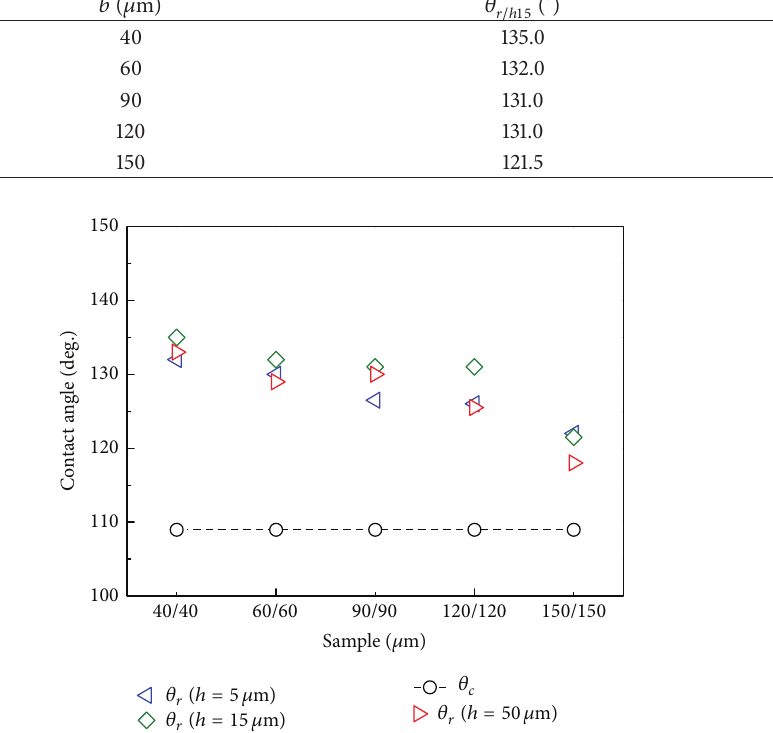
Figure 2: Effect of groove size ( 𝑎 and 𝑏 ) for constant width/spacing ratio. Dashed line denotes the CAs calculated from Cassie-Baxter model.